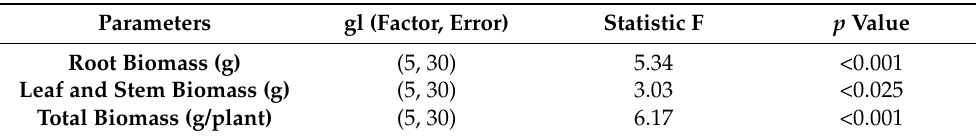
Table 4. ANOVA of a pathway of the parameters of biomass of root, leaves, and stems, and to- tal biomass of the seedlings of Rhizophora mangle in the ponds with treatments at the end of the experiment, with a significance level of p <